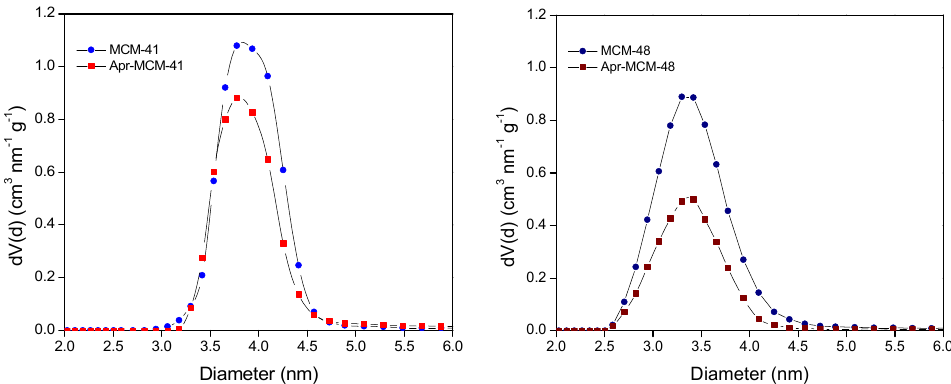
Figure 9. Non-Local Density Functional Theory (NLDFT) pore size distributions of pristine and aprepitant-loaded MCM-41 ( left ) and MCM-48 ( right ).